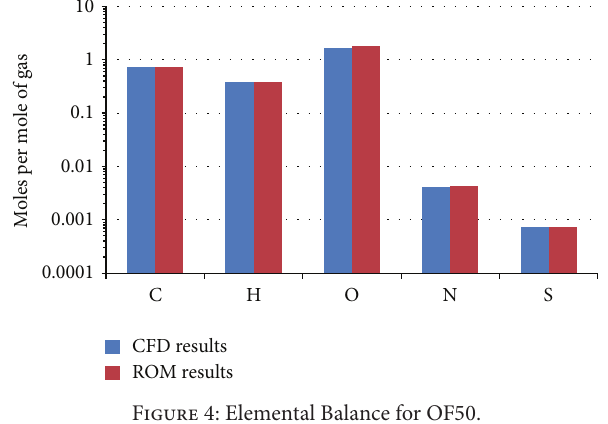
Figure 4: Elemental Balance for OF50.